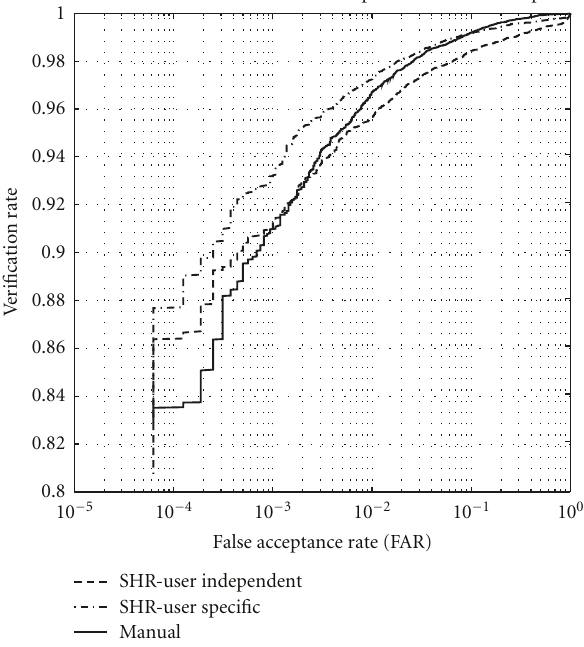
Figure 10: Comparison of user-independent and user-specific